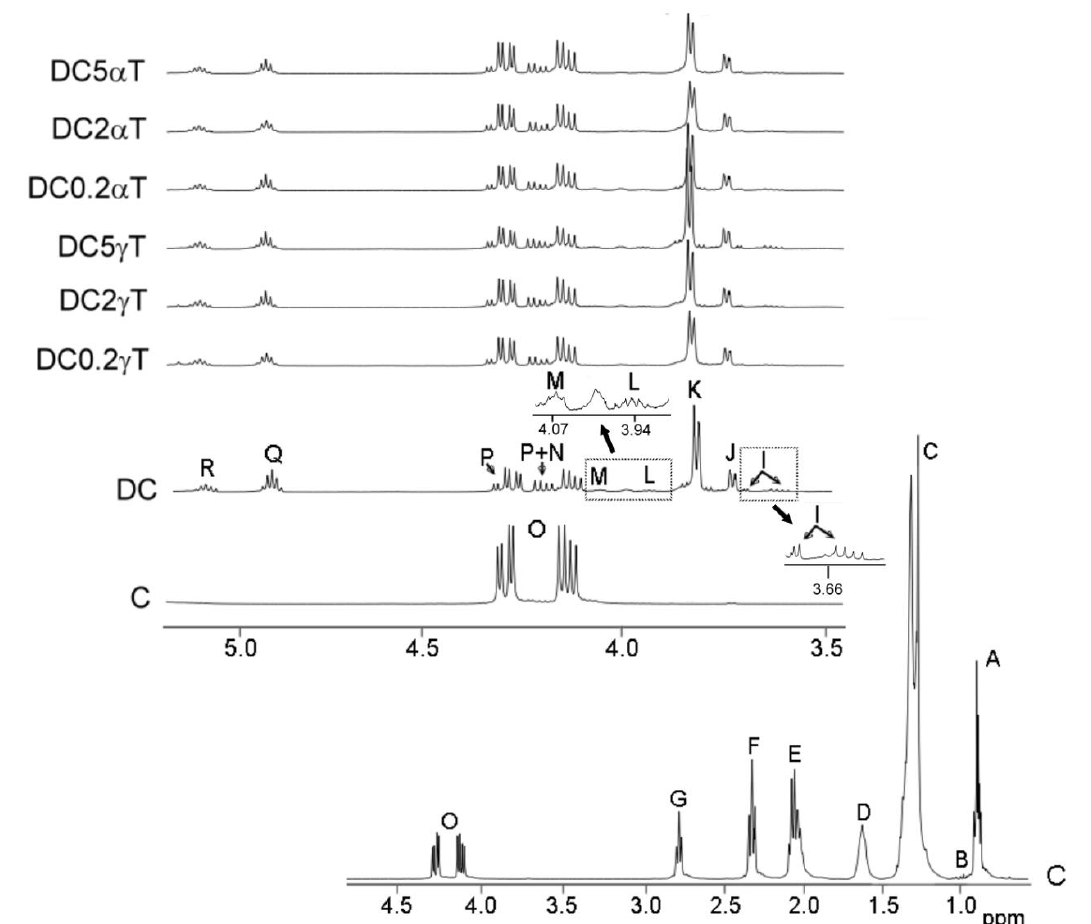
Figure 1. Region comprised between 0.0 and 4.9 ppm, of corn oil C 1 H NMR spectrum, and region comprised between 3.5 ppm and 5.10 ppm, conveniently enlarged, of the 1 H NMR spectra of the oil C and of the lipids extracted from the several digestates (DC, DC0.2 γ T, DC2 γ T, DC5 γ T and DC0.2 α T, DC2 α T, DC5 α T), in which signals of protons of their main components appear. The signal letters agree with those of Tables S2 and S3.